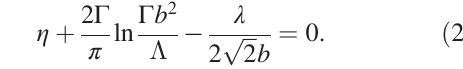
FIG. 5. The mean-field solution for b as a function of obtained by numerically using Eqs. (25). We have set ε ¼ − 6 Γ and the bandwidth Λ ¼ 30 Γ in the